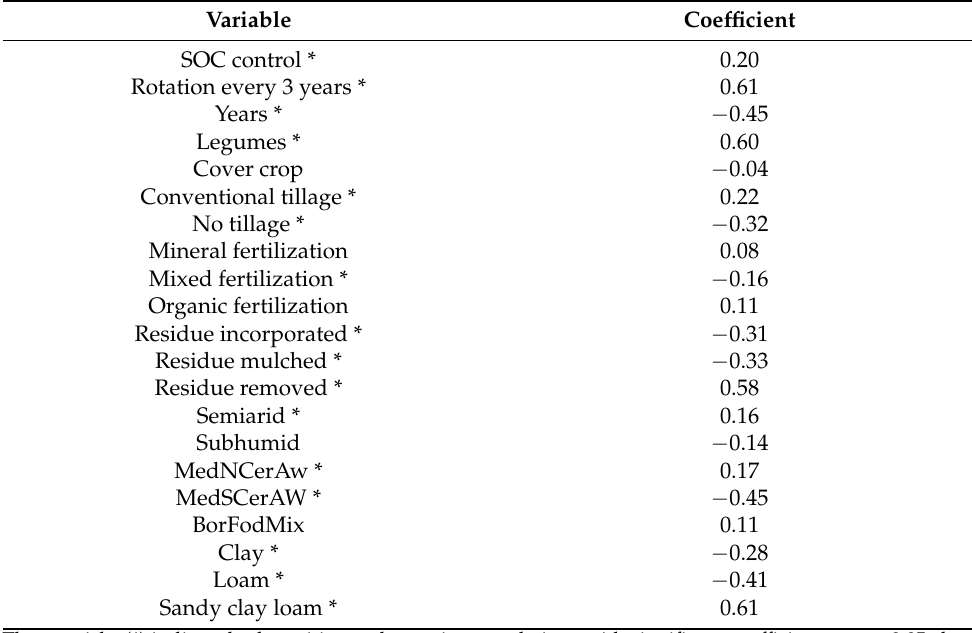
Table 4. Spearman rank correlation coefficients (rs) for changes in SOC content and the predictive variables for crop diversification. Authors’ data based on